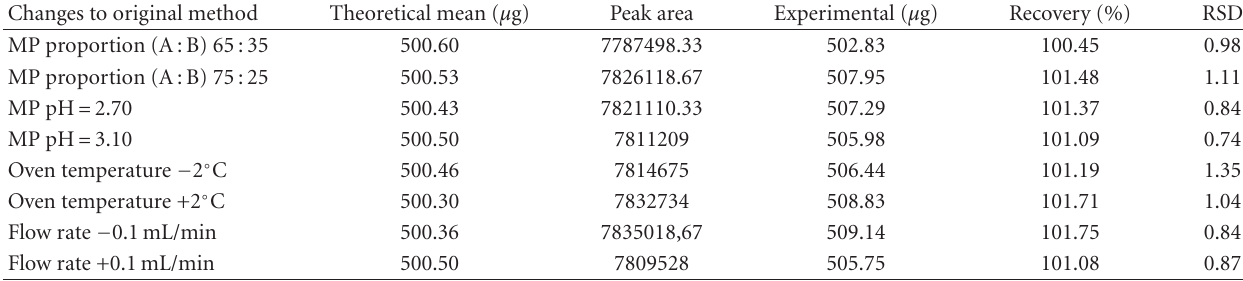
Table 2: Robustness test of proposed method in terms of recovery (%) and RSD (%) for 500 µ g/mL CB13 standard ( n = 3) (MP: mobile phase).